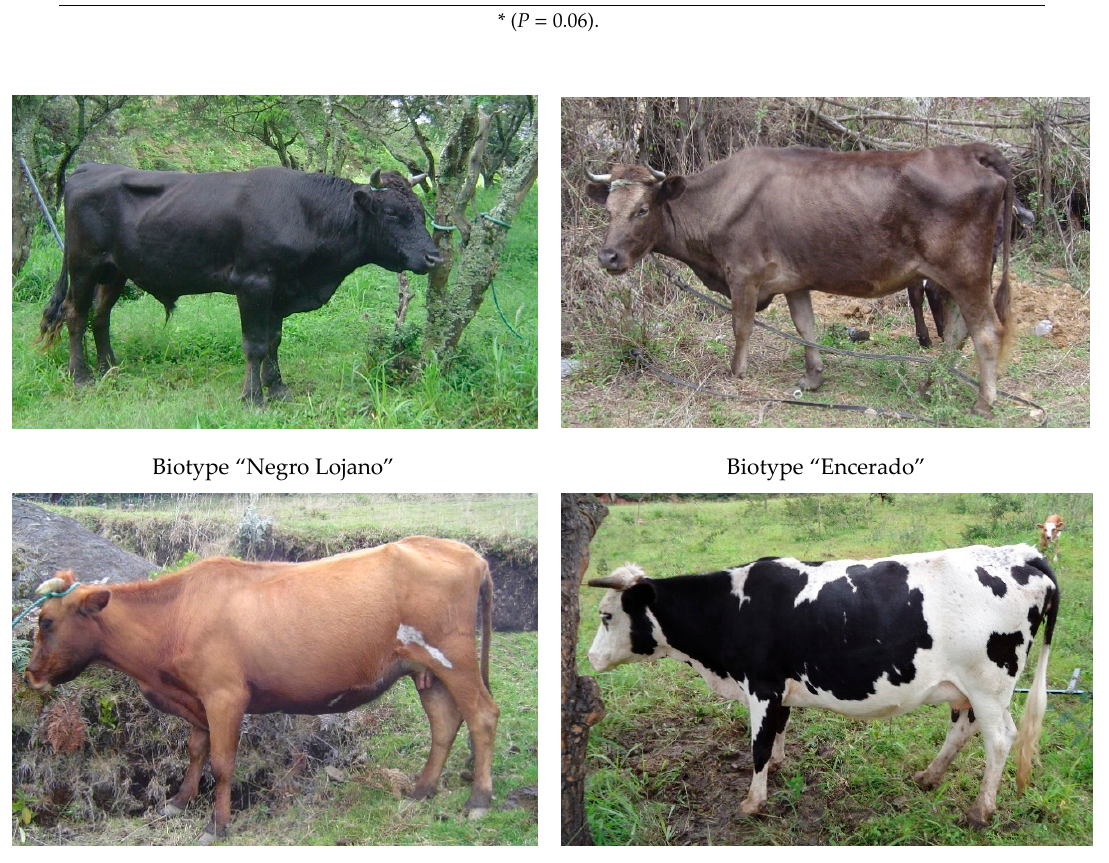
Figure 2. Criollo Lojano of all four biotypes.